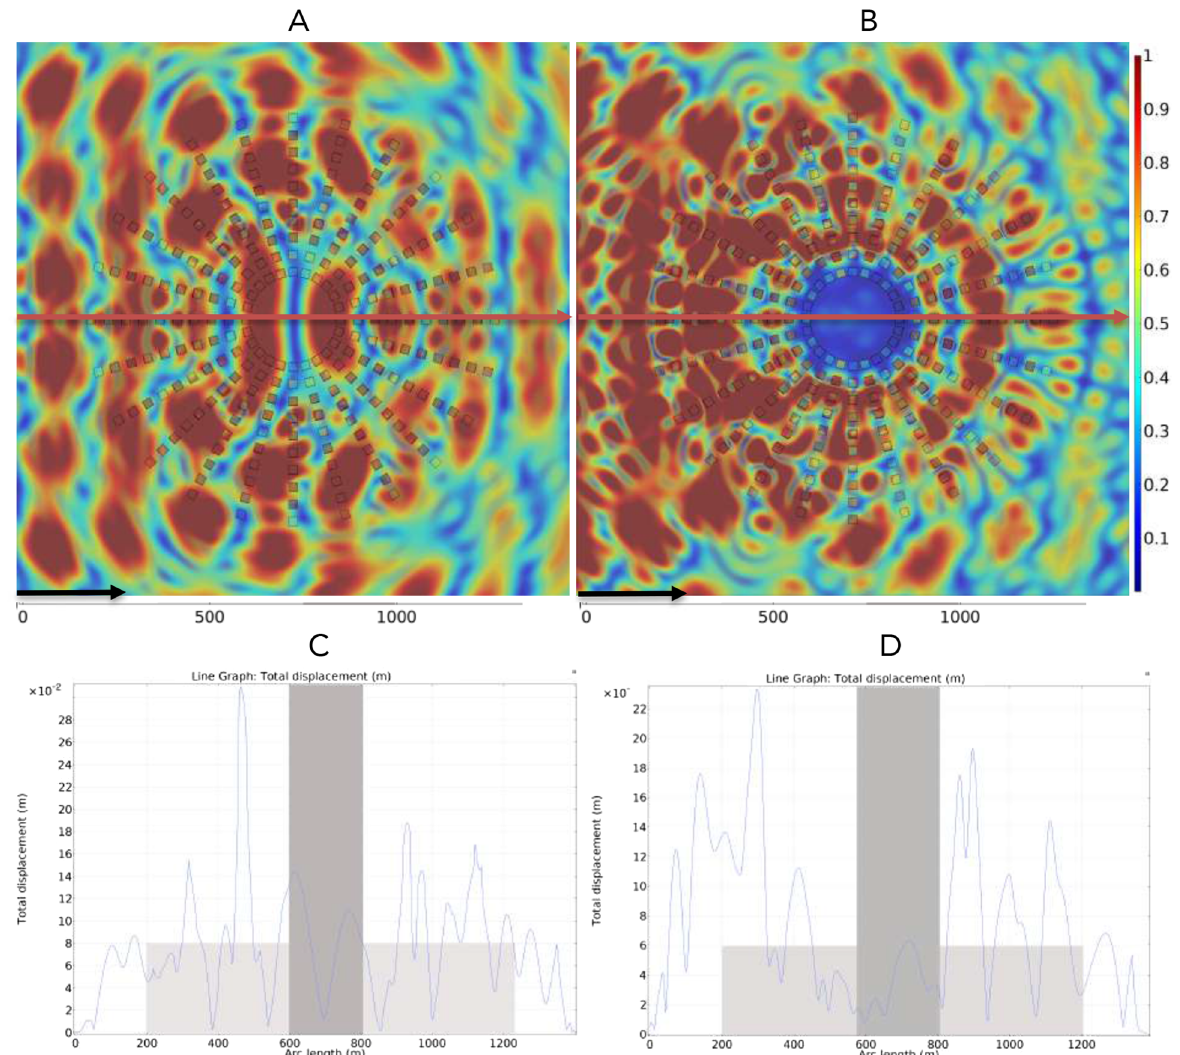
Fig. 5. Scattering of the metacity cloak by a plane wave source at 10 Hz; (A) concrete buildings on a concrete plate ( E = 25e9 [Pa], r = 2300 [kg/m 3 ], n = 0.2); (B) steel buildings ( E = 200e9 [Pa], r = 7870 [kg/m 3 ], n = 0.29) on a concrete plate. Color scale is as in Figure 4. One notes the antagonistic behavior of the fi eld inside the core of the cloaks in (A), (C) and (B),